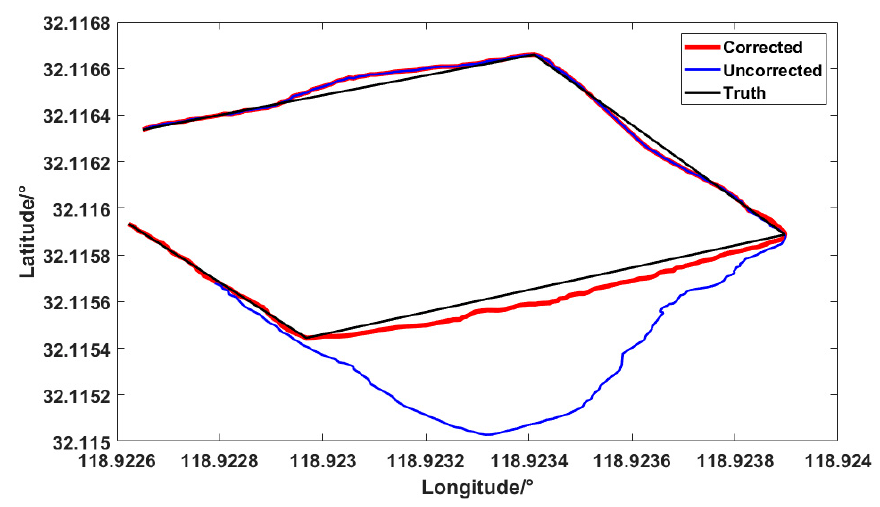
Figure 16. Track of seamless the indoor/outdoor movement. Table 4. Test Occasion 4: Mean and STD of the positioning error of the seamless indoor/outdoor positioning.